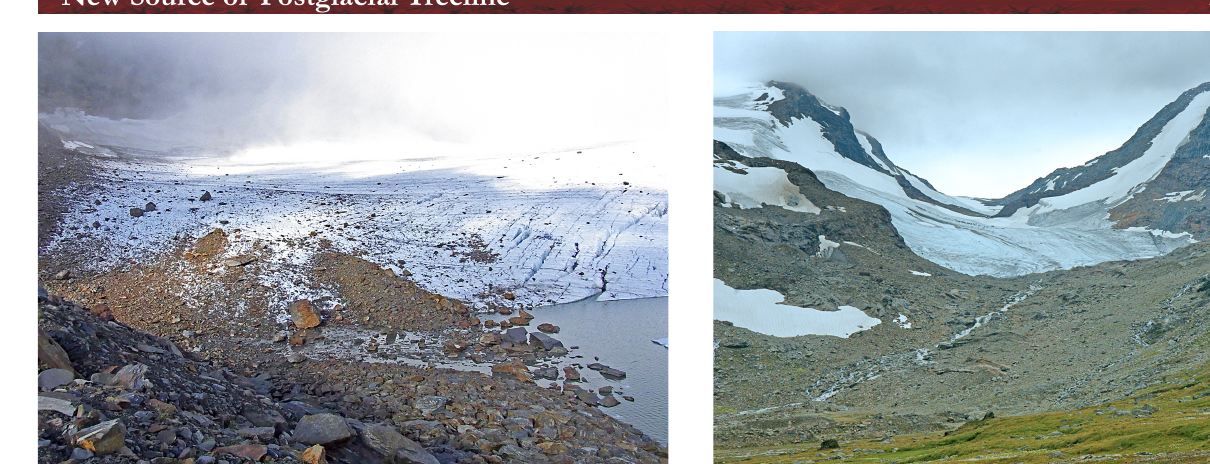
Figure 12: Kårsajökeln (12) and its extensive forefield, which has become freed of ice during the past century. 2009-08-21.